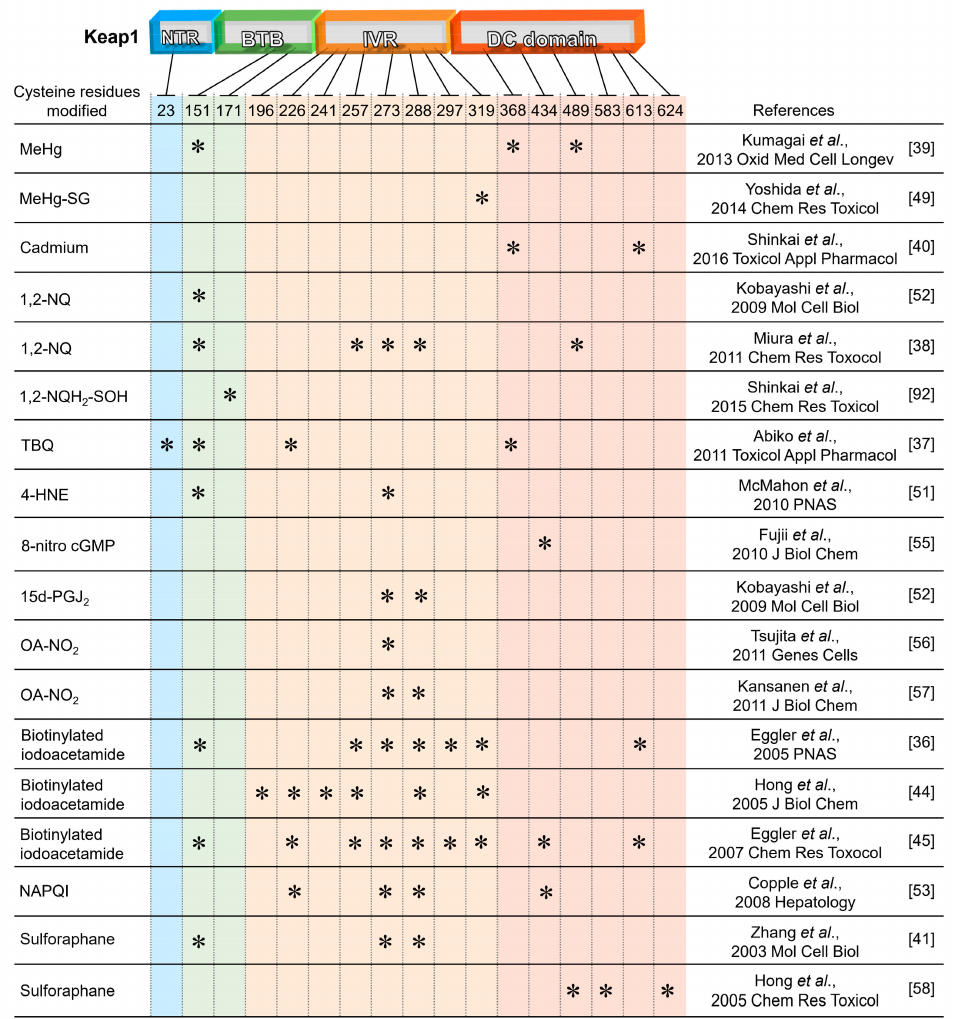
Figure 2. The cysteine code of Keap1 modification sites with various electrophiles. The BTB (Board complex, Tramtrack and Bric- à -brac), IVR (intervening region) and DC (DGR / CTR: double glycine repeat / C-terminal region) domains are essential for the Keap1 homodimerization, heterodimerization withCul3andthebindingofNrf2, respectively. *,